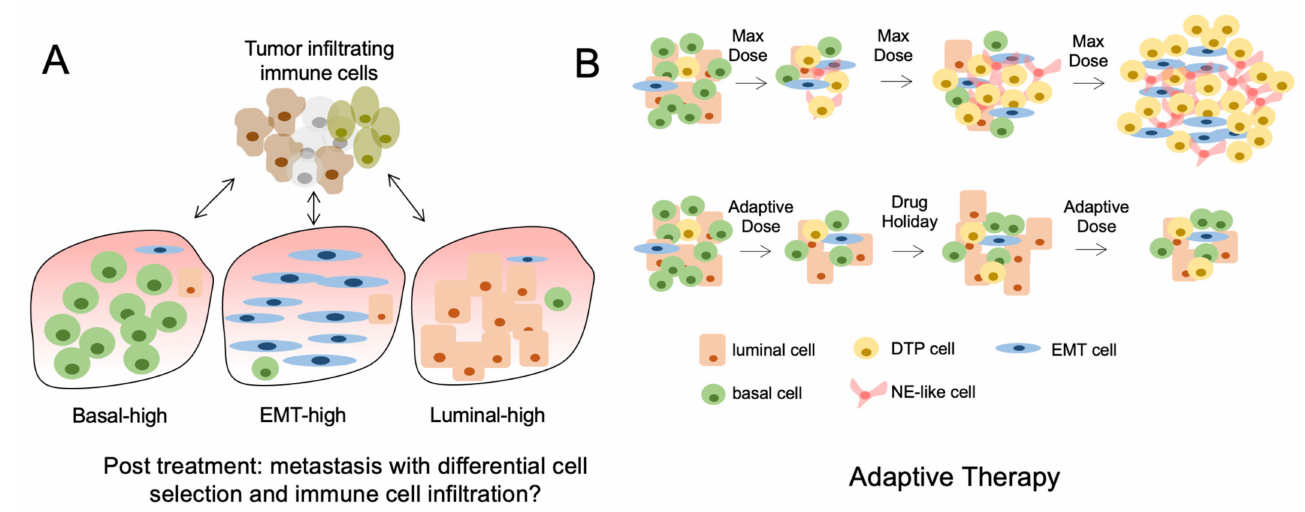
Figure 2. Tumor heterogeneity and the consequences of treatment. ( A ) The lineage composition of post-treatment metastatic tumors can differ significantly because of nonmutational and mutational mechanisms causing differential subpopulation selection. This results in altered immune cell infiltration and response to immune therapies. ( B ) The use of maximum tolerated dose (MTD) of drugs causes initial tumor regression but rapid acquisition of drug resistant tumor cells or DTPs (top). Conversely, the cycled use of drugs at lower doses can prolong the effects of cancer therapies and reduce the acquisition of DTPs